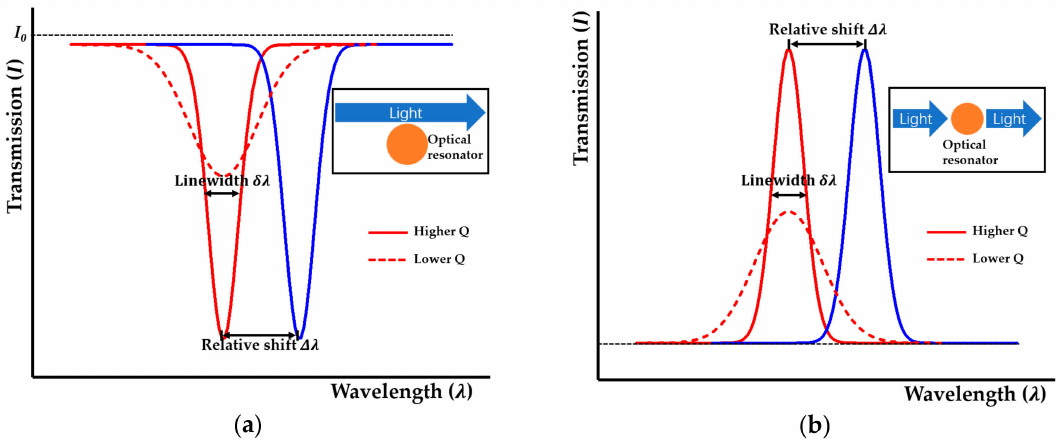
Figure 1. Transmission spectrum of an optical microcavity: ( a ) a characteristic dip at resonance wavelength for side-coupled cavity; ( b ) a characteristic peak at resonance wavelength for the input-cavity-output configuration. The resonance wavelength shifts from the red line to blue line due to the physical or chemical variations in optical mode region. In addition, the decrease of Q factor causes the expansion of spectral resonance line width ( δλ